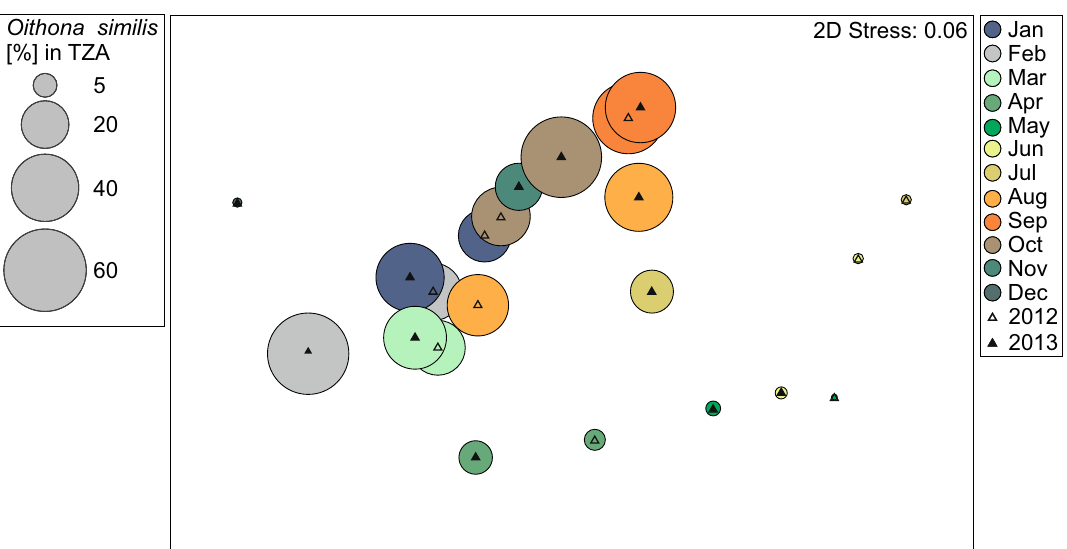
Figure 4. Two-dimensional non-metric multidimensional scaling (nMDS) ordination of the overall similarity in zooplankton taxonomic composition (the closer the points the more similar species composition). The relative sizes of the bubbles represents the share (%) of Oithona similis related to the total zooplankton abundance